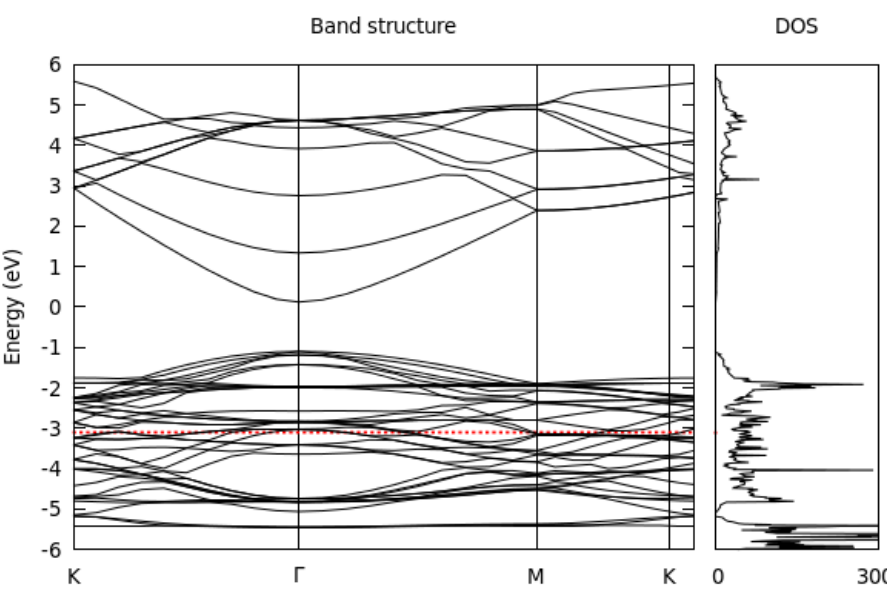
Figure 4: Band structure and DOS of ZnO in the three-layer graphene-like structure. The red dashed line is the Fermi level found for wurtzite.